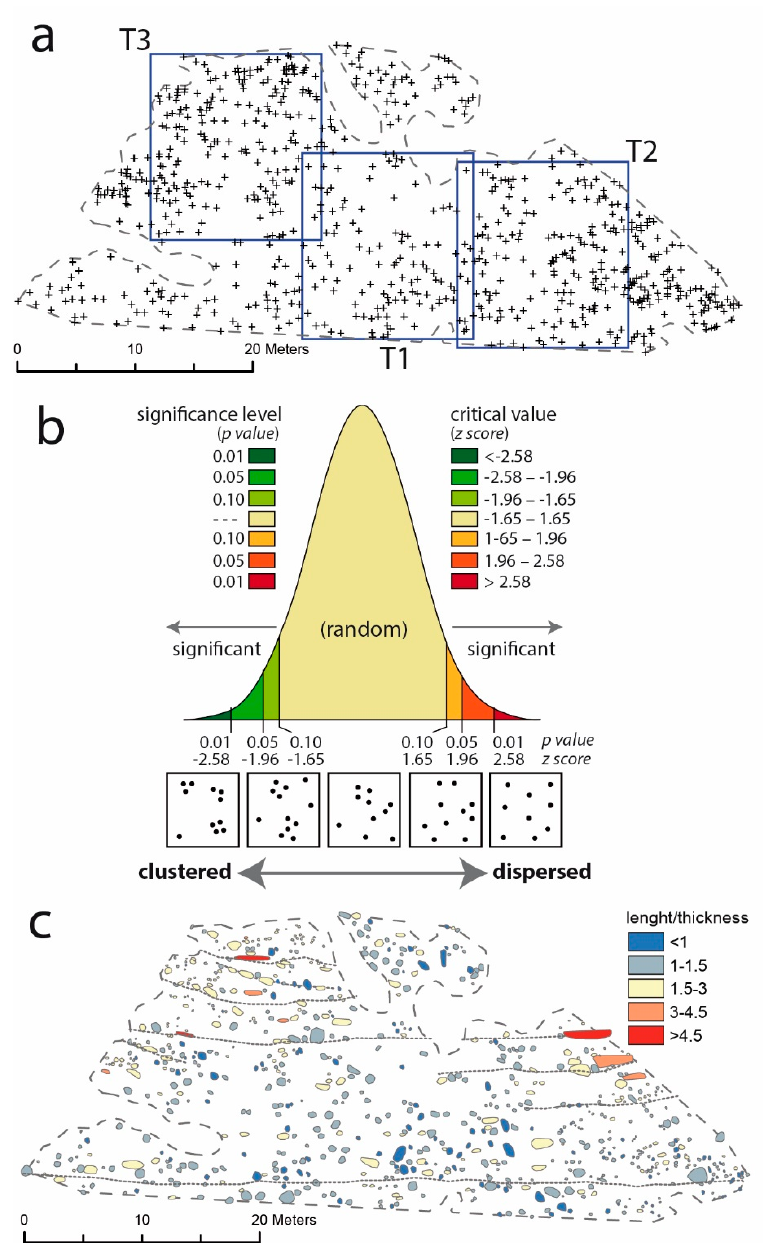
Figure 10. ( a ) Centroids of concretions from the near vertical face of the studied outcrop (see Figure 3d for location) with test areas (T1–T3) used for computing Average Nearest Neighbour Statistics reported in Table 2; ( b ) Explanation of z ‐ scores (standard deviation), p ‐ values (probability) and associated significance level thresholds for the normal standard distribution of a random process; ( c ) Concretion boundaries classified by their w / t ratio. Note how larger and more elongated concretions appear clustered spatially being aligned along bedding (dashed lines).